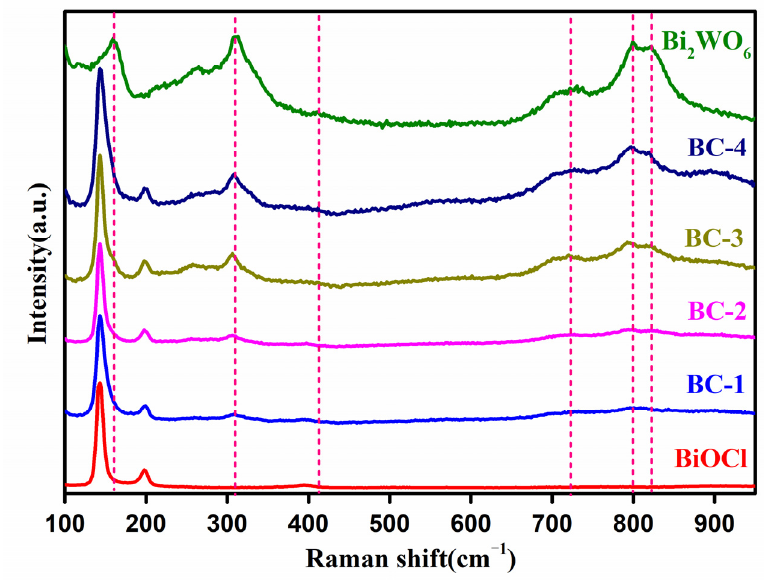
Figure 2. Raman spectra of BiOCl, Bi 2 WO 6 , and Bi 2 WO 6 /BiOCl nanocomposites.